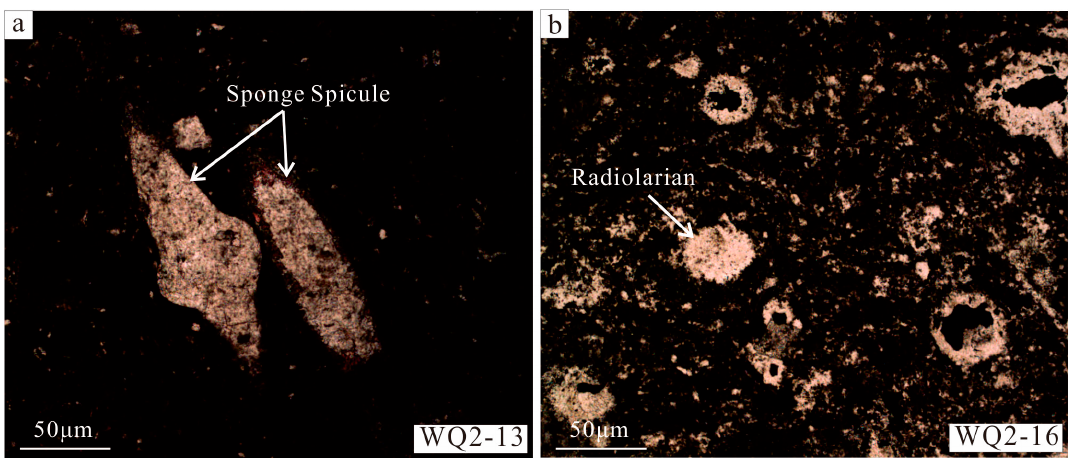
Figure 8. Photomicrographs of some siliceous organisms in the collected shale samples (plane-polarized light). ( a ) Sponge spicule with monaxonid megascleres; ( b ) Radiolarian belonging to the Phaeodaria group.